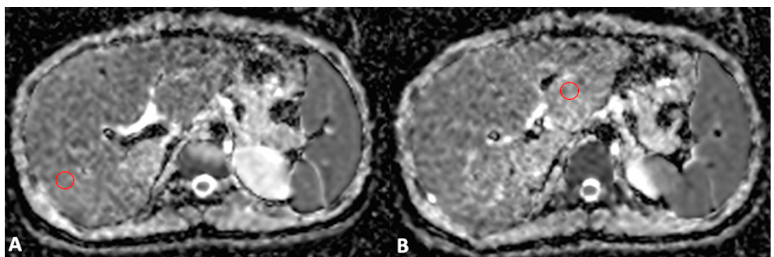
Figure 1. Axial MRI ADC map scans through the right ( A ) and left ( B ) portal veins. Two ROIs with a maximal diameter of 1 cm were drawn for the right ( A ) and left ( B ) lobes, excluding the great vessels and motion artefacts, to obtain a representative ADC value of the liver parenchyma.